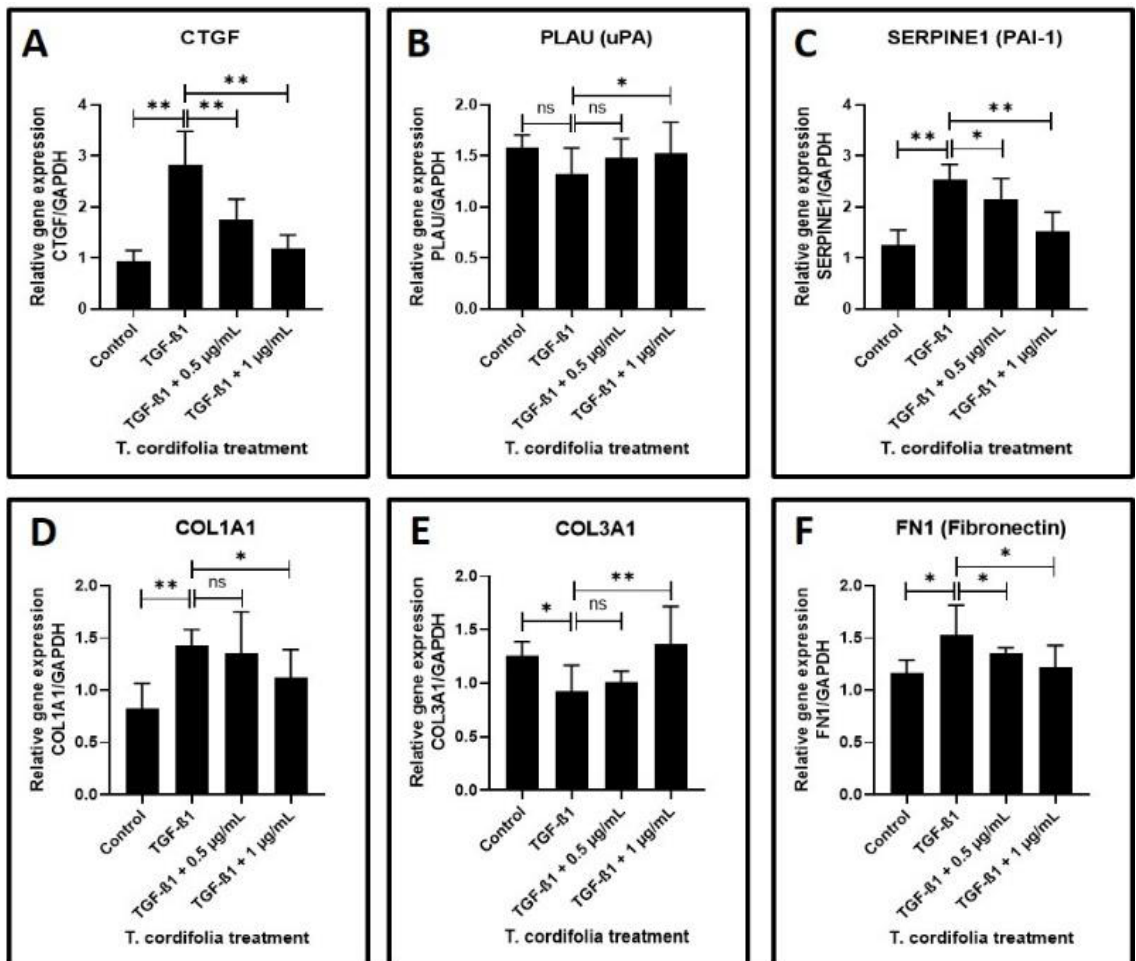
Figure 2. Analysis of gene expression by quantitative RT-PCR. ( A ) Fibrosis was induced by TGF- β 1 in the oral keratinocytes and comparative gene expression analysis was carried out in the fibrosis-induced oral keratinocytes treated with various concentrations of TcE for matricellular protein-related gene expression for CTGF. ( B , C ) Fibrosis was induced by TGF- β 1 in the oral keratinocytes and comparative gene expression analysis was carried out in the fibrosis-induced oral keratinocytes treated with various concentrations of TcE for plasmin system regulator protein-related gene expression for PLAU and SERPINE1. ( D – F ) Fibrosis was induced by TGF- β 1 in the oral keratinocytes and comparative gene expression analysis was carried out in the fibrosis-induced oral keratinocytes treated with various concentrations of TcE for structural matrix protein-related gene expression for COL1A1, COL3A1, and FN1. ns—not significant, * p < 0.05, ** p < 0.001. CTGF: CCN2 or connective tissue growth factor, PLAU: Plasminogen activator, urokinase ( µ PA), SERPINE1: plasminogen activator inhibitor 1 (PAI-1), COL1A1: Collagen type I alpha-1, COL3A1: Collagen type III alpha-1, FN1: